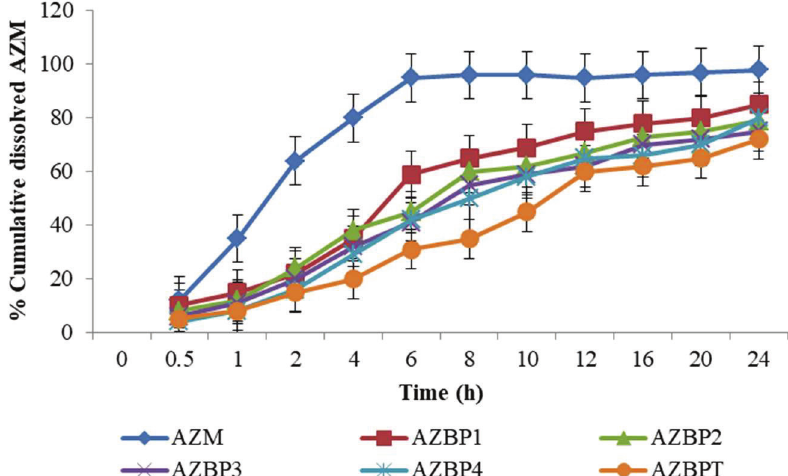
Fig. 4. Dissolution rate of AZM microparticles prepared from beeswax (values represent mean±SD, n =6)